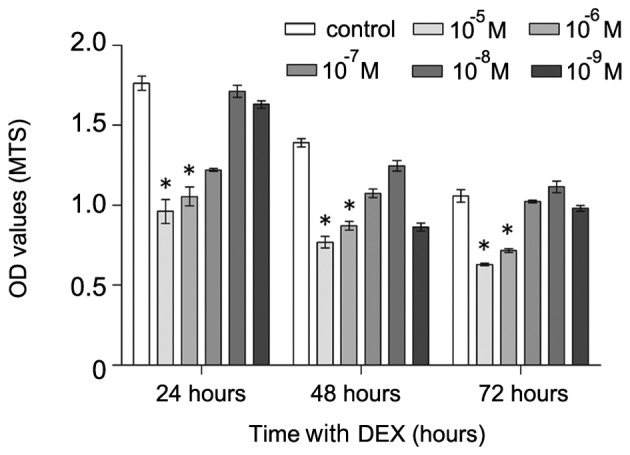
DEX inhibits hFOB1.19 cell proliferation. Cell proliferation was measured using an MTS detection kit following pretreatment of the cells with 0 M and 10−5–10−9 M DEX for 24, 48 and 72 h. Treatment with 10−5 and 10−6 M DEX significantly reduced cell proliferation. Data are presented as the mean ± standard deviation. *P<0.05, vs. control. DEX, dexamethasone; OD, optical density.